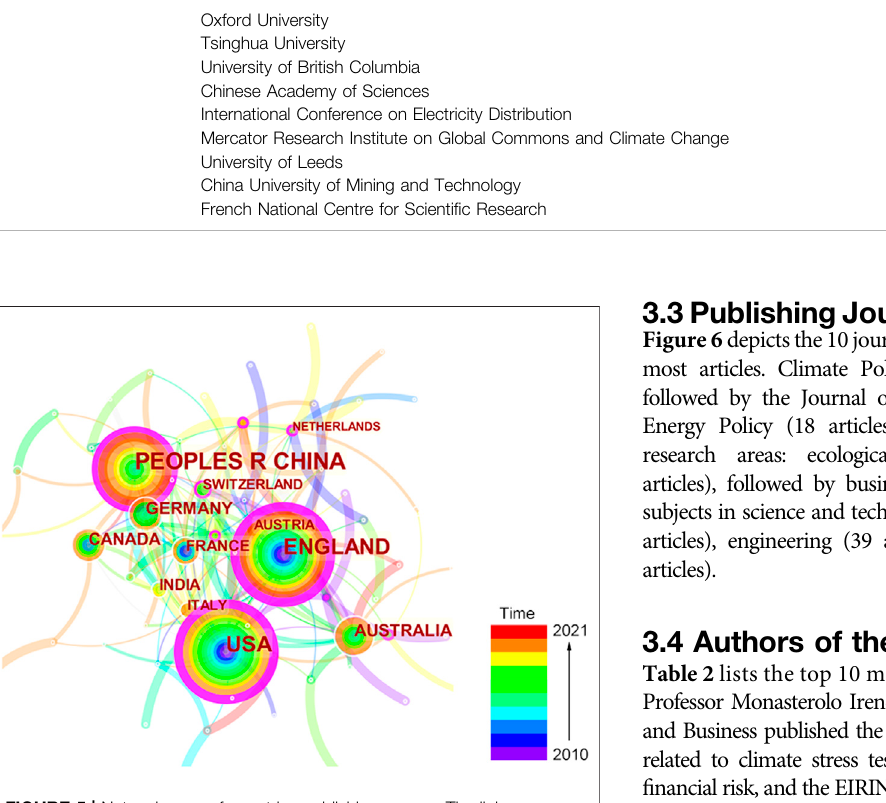
FIGURE 5 | Network map of countries publishing papers. The links indicates cooperation between the related countries, and the colours represent the dates of the cooperation. The size of a circle is proportional to the number of studies contributed by countries or regions.